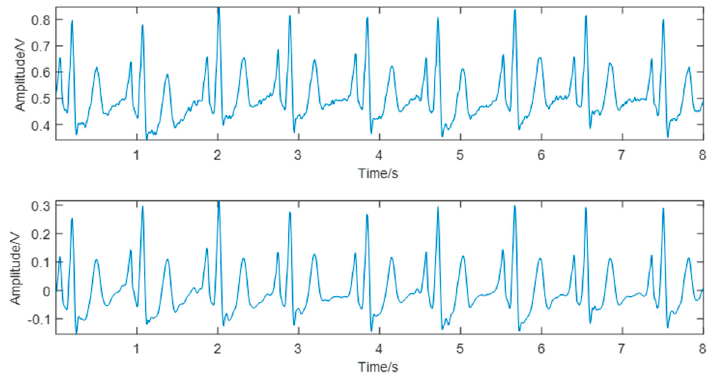
Figure 4. Comparison of the electrocardiogram (ECG) signal before (top) and after (bottom) denoising.